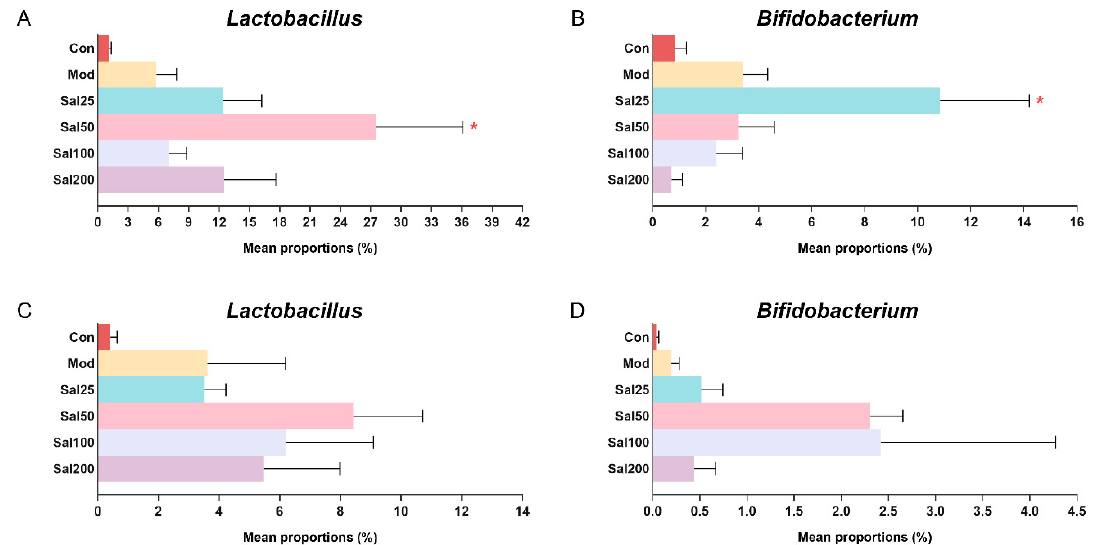
Figure 5. The effects of salidroside on probiotic abundance. ( A , C ) The abundance of Lactobacillus after 7 and 14 days, respectively. ( B , D ) The abundance of Bifidobacterium after 7 and 14 days, respectively. * p < 0.05 compared with the Mod group.